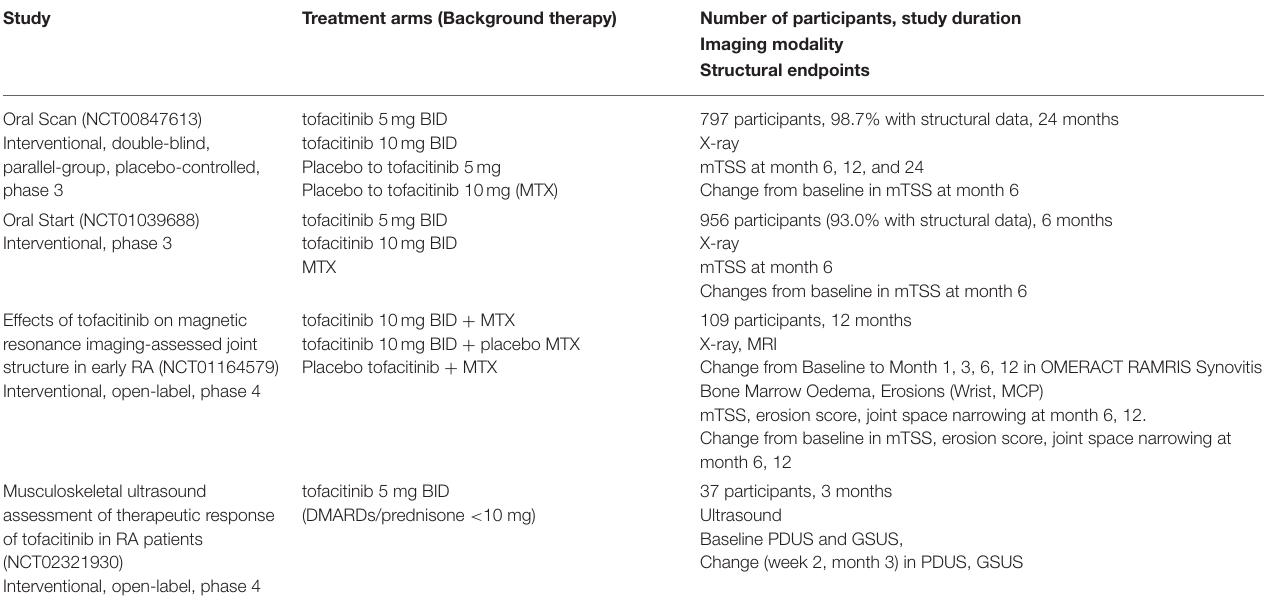
TABLE 2 | Clinical trials in which jakinib effects were assessed on structural joint changes and synovitis.